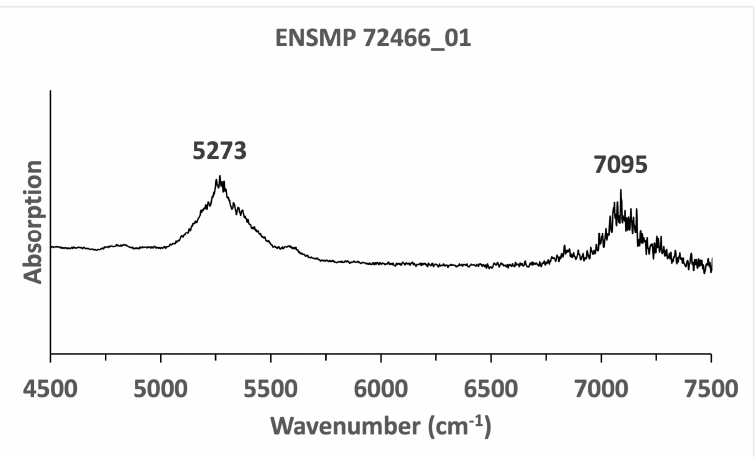
Figure 9. FTIR spectra of a single-crystal (ENSMP 72466_01) Egyptian emerald parallel to c-axis. The intense presence of peaks at 5273 cm − 1 and 7095 cm − 1 (about 1410 nm) are related to the presence of Type II water molecules.